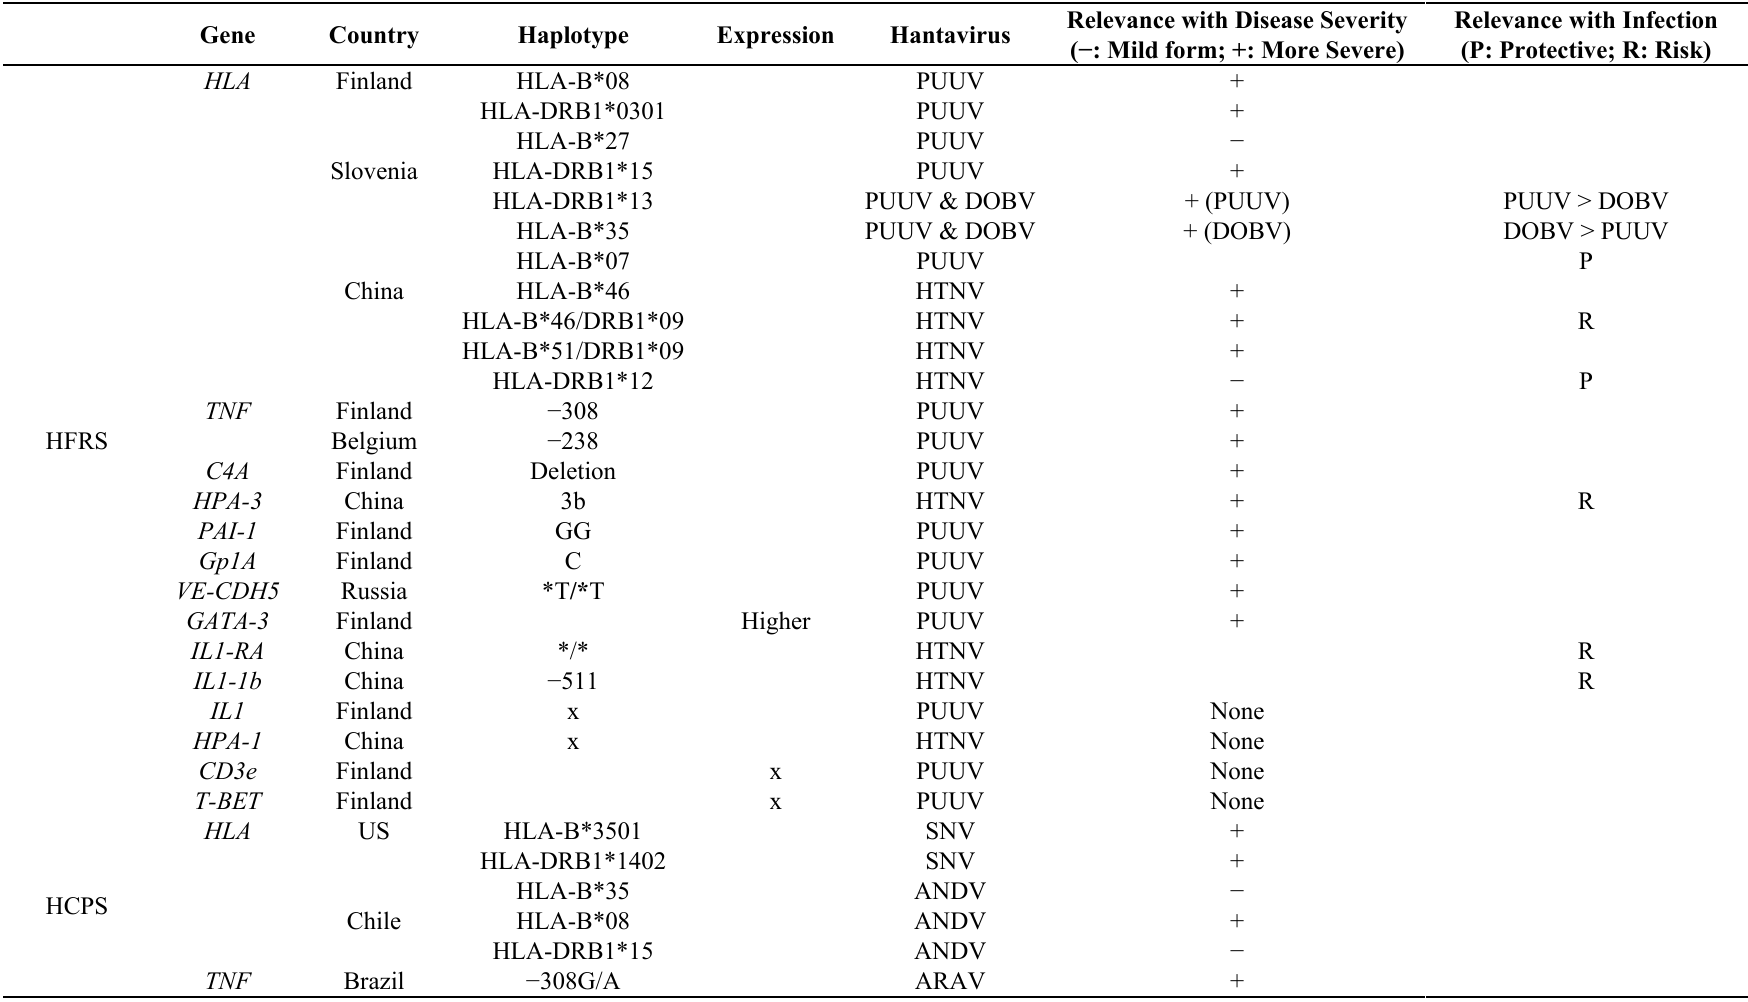
Table 1. Immunity-related genes associated with the severity of hantavirus disease in